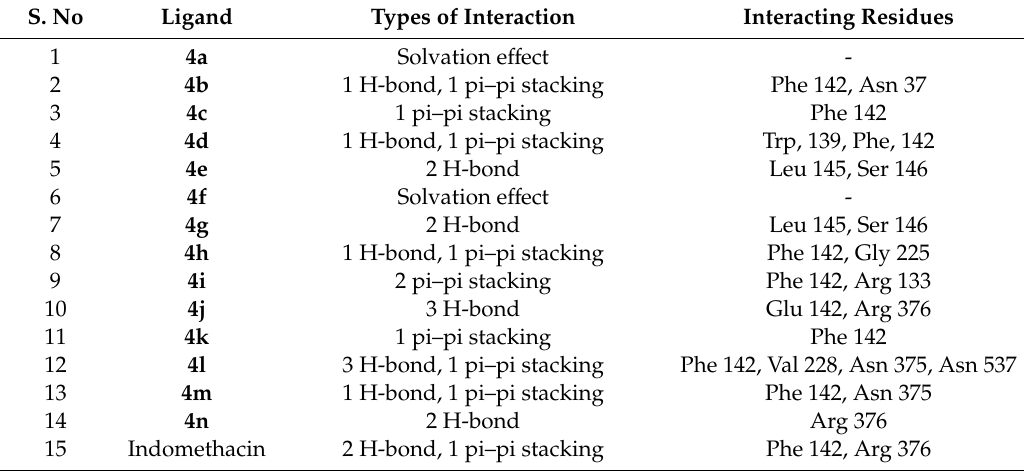
Table 6. Type of interaction and amino acid residues involved in that interaction inside the binding pocket of the Cox-2 enzyme from mouse (4NT1).